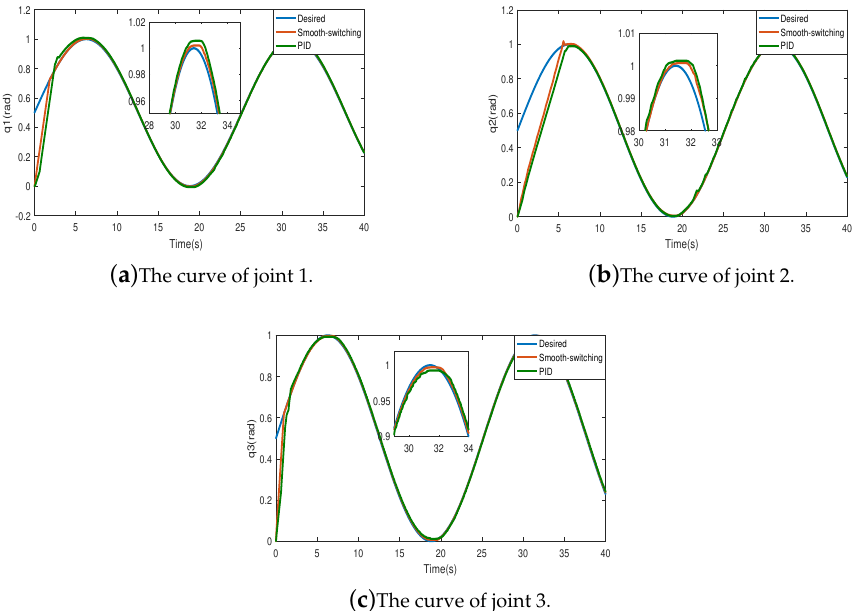
( c ) The curve of joint 3. Figure 10. Comparison curve of tracking error between PID and smooth-switching with q d = 0.5 + 0.5sin ( 0.25 π t ) and σ =